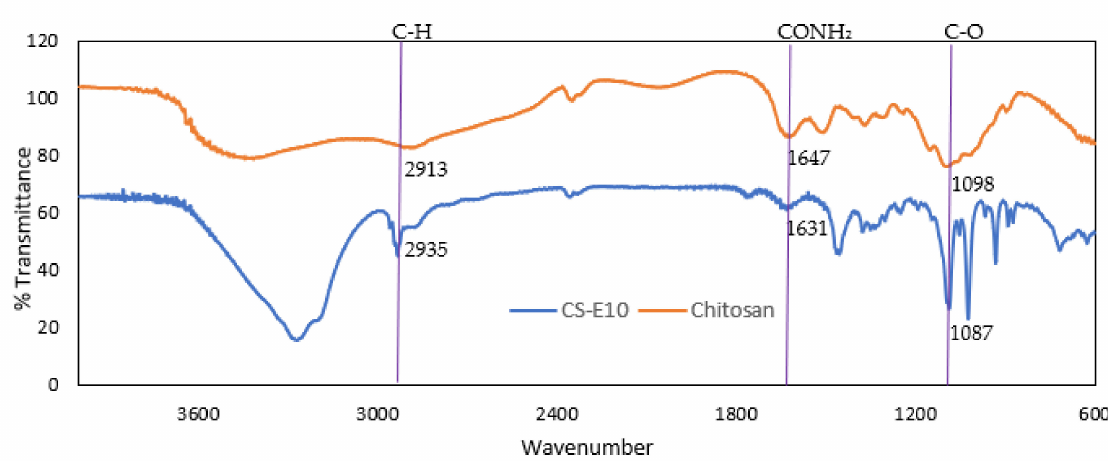
Figure 8. FTIR spectra of chitosan and chitosan-coated PLGA NPs (CS-E10) highlighting the functional